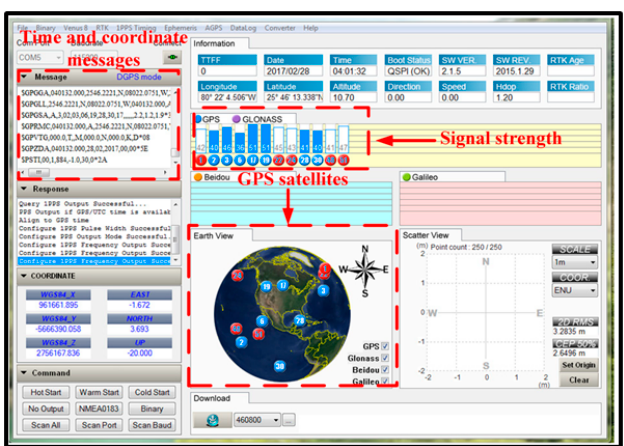
Figure 17. The GPS software control panel.